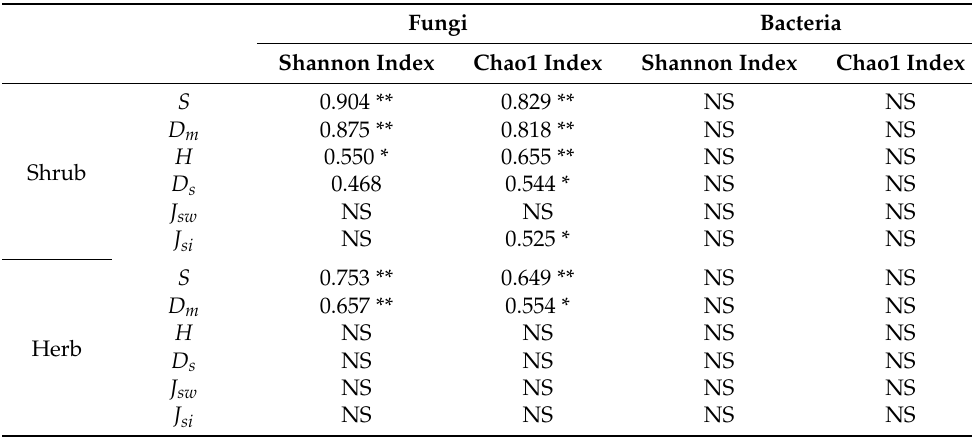
Table 7. Correlation analysis between soil microbial diversities and undergrowth vegetation species diversities. Asterisks represent the p -value: * = p < 0.05, ** = p < 0.01. NS = non-significant. Fungi Bacteria Shannon Index Chao1 Index Shannon Index Chao1 Index